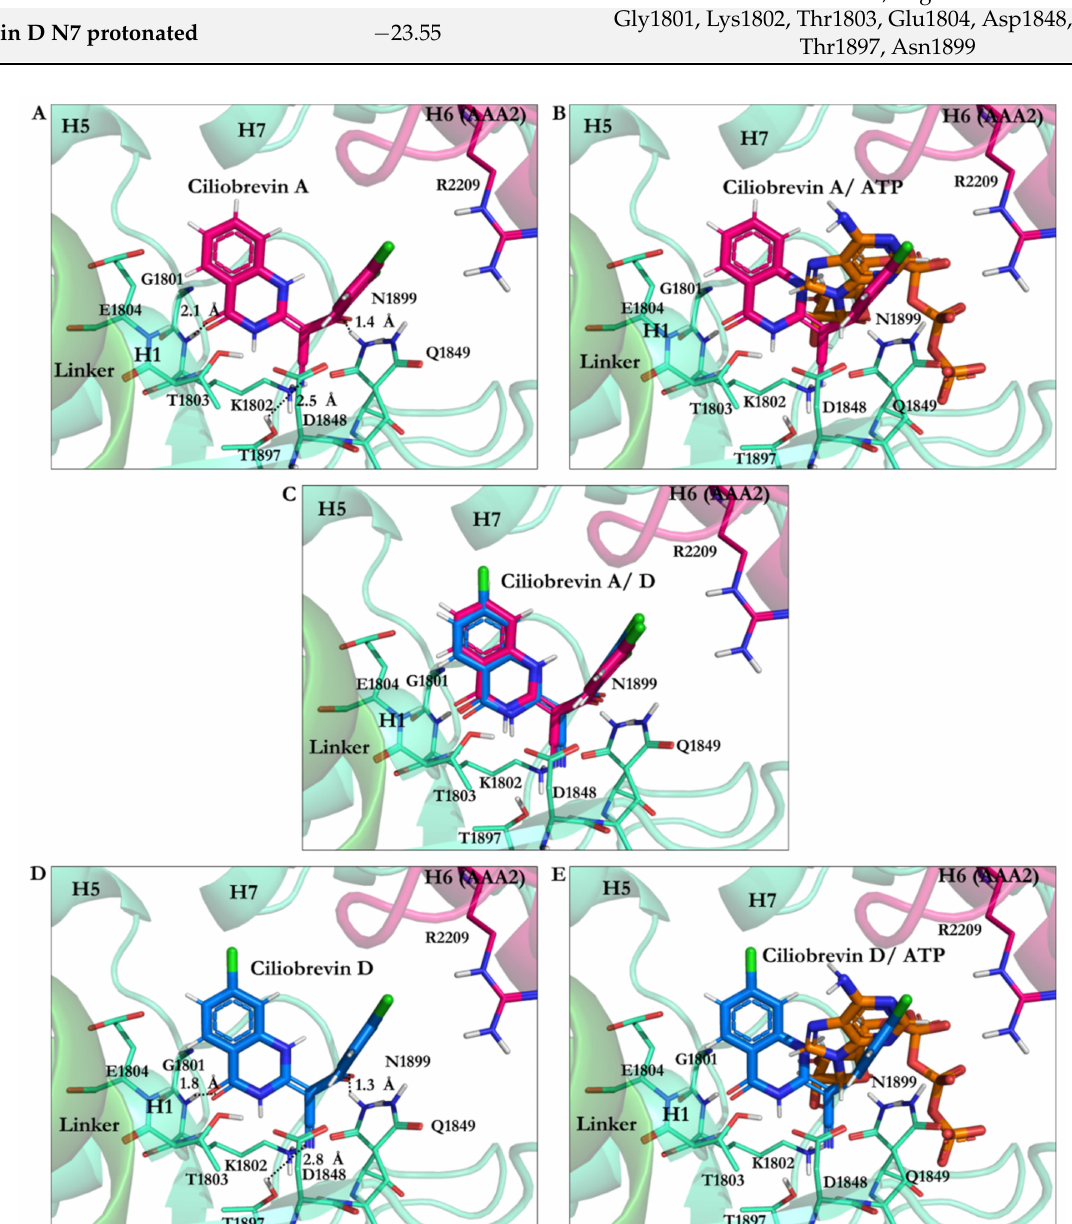
Figure 8. Ciliobrevin A and D conformation at the AAA1 binding site of motor domain of dynein 1. ( A ) Ciliobrevin A and ( B ) Ciliobrevin A superimposed on ATP. ( C ) Ciliobrevin A and ciliobrevin D superimposed. ( D ) Ciliobrevin D and ( E ) Ciliobrevin D superimposed on